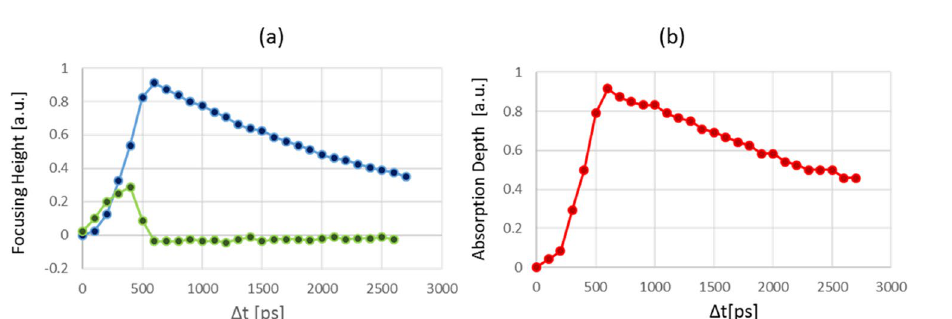
Figure 6. The focusing dynamics. Here is a sequence of 3-D images of the probe IR beam inside the silicon sample as taken with the InGaAs camera vs the pump–probe delay time. The best focusing we get in this experiment appears at pump–probe delay time of ∼ 600 ps, and the absorption depth ring (the trench around the focusing peak) gets its maximum on the same delay time. The X, Y axis are in μm, and the pump donut beam is shaped by vortex order 2. The laser pulse repetition rate is 40 kHz.The optical axis is in the Z direction.